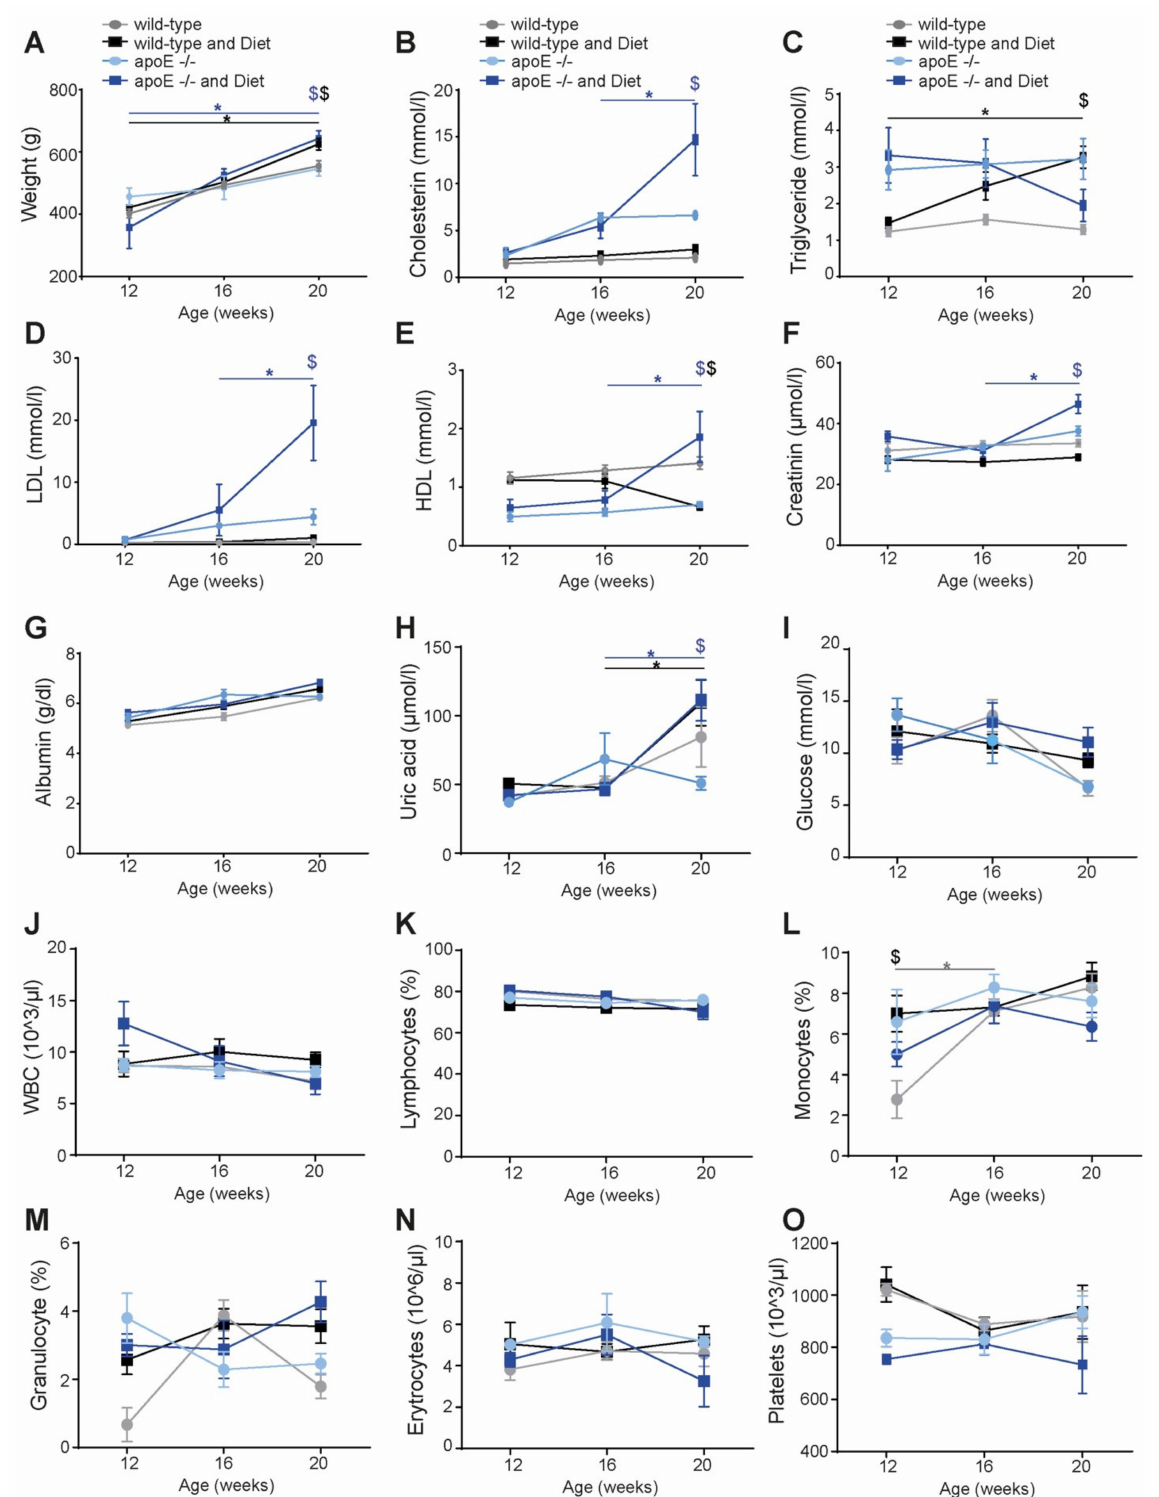
Figure 1. Blood analysis of apoE − / − rats at different time points under feeding high-fat diet ( A – O ). Indicated parameters and cell components were determined after 4 weeks (age 12 weeks), 8 weeks (age 16 weeks) and 12 weeks (age 20 weeks), respectively ( n = 5–15), under normal diet (bright blue for apoE − / − and grey for wild-type rats) or high-fat diet (dark blue for apoE − / − and black for wild-type rats). * p < 0.05 vs. earlier time points, $ p < 0.05 high-fat vs. normal diet (in black for wild-type and in blue for apoE − / −